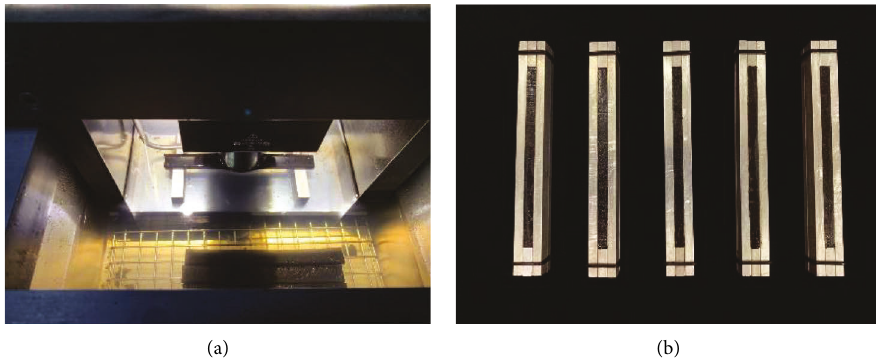
Figure 3: BBR test: (a) BBR loading module and (b) rectangular asphalt samples.